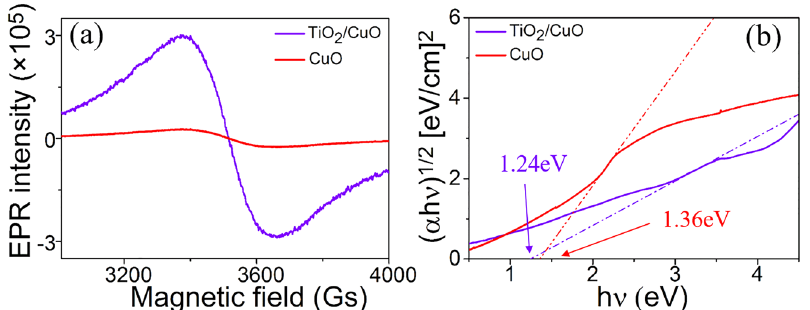
Figure 3: (a) Electron paramagnetic resonance (EPR) spectrum. (b) Optical absorption spectrum of cupric oxide (CuO) nanosheets and TiO 2 /CuO